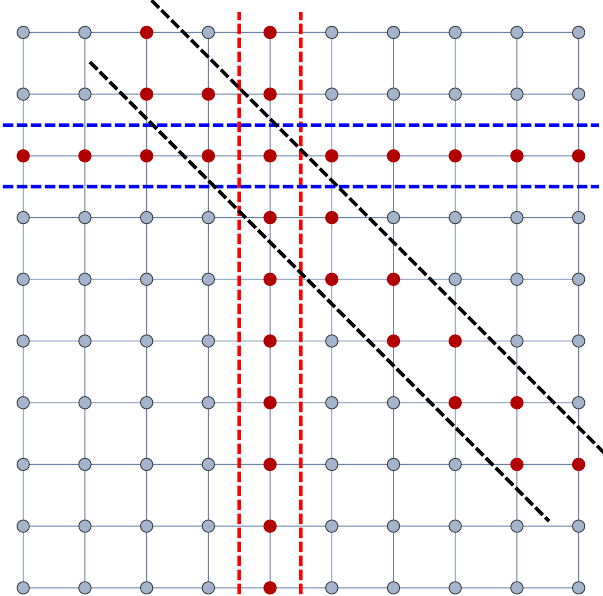
Figure 5 . We consider three kind of strips: the red vertical one is H 2 ((cid:22) h ), the blue horizontal